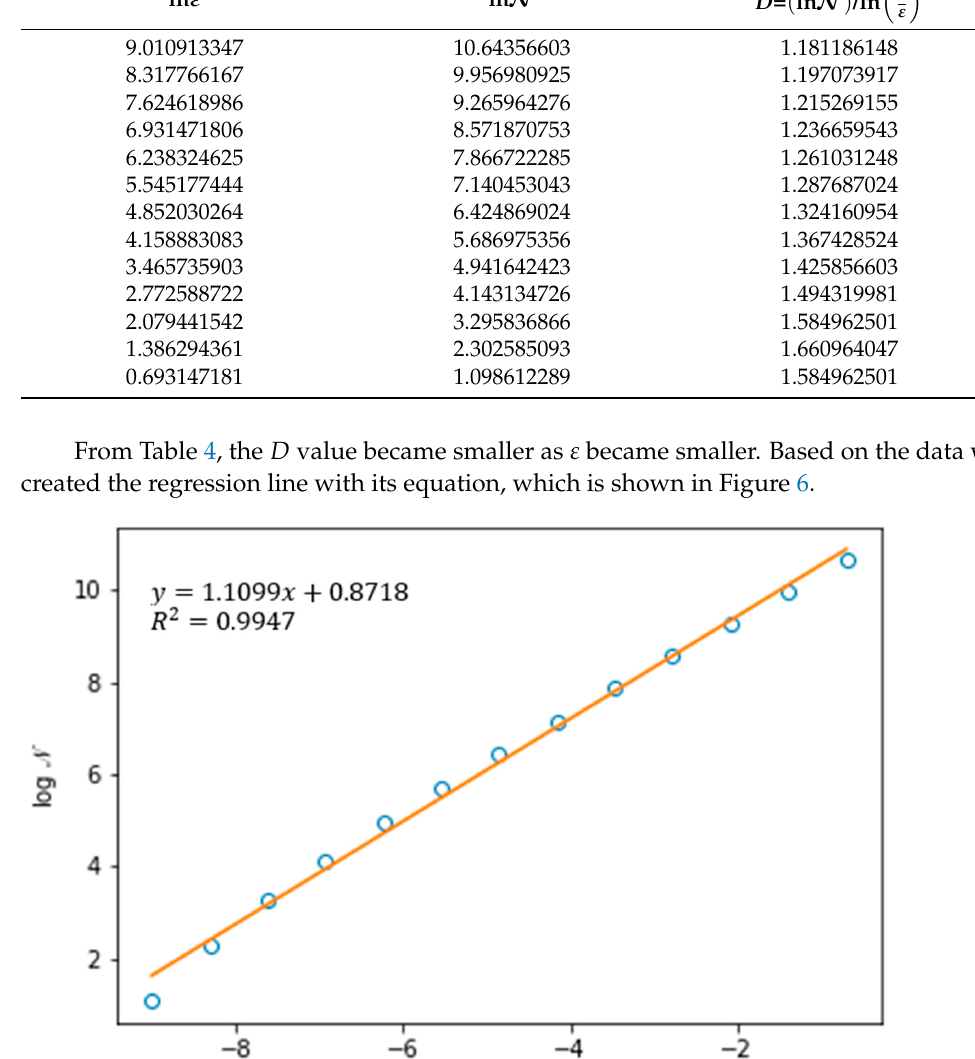
Table 4. Values of ln 𝜀 , ln 𝒩 , and 𝐷 for each 𝑛 .